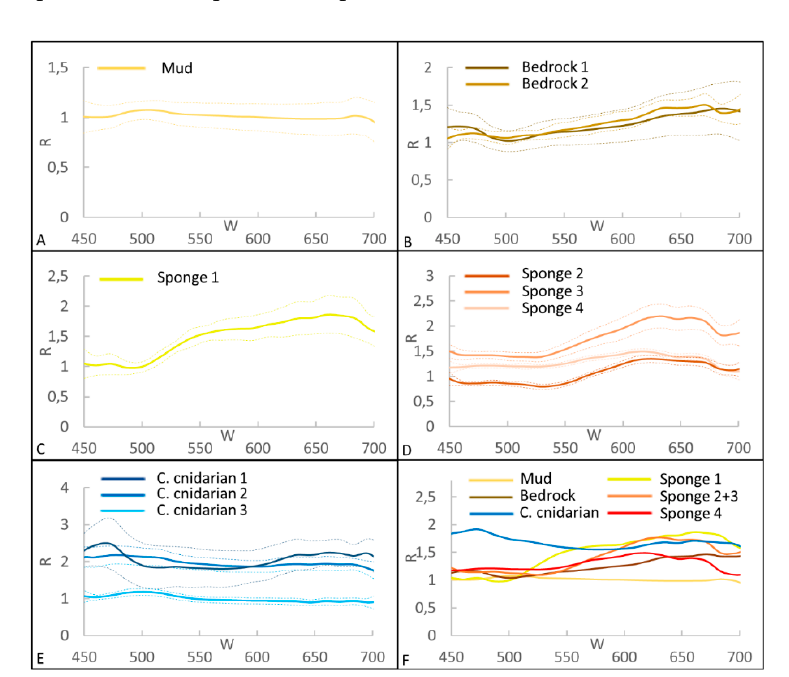
Figure 2. Mean spectra of the ROIs for the CWC site. R is the reflectance and W the wavelength. In A , B , C , D and E , dashed lines represent the standard deviation. F shows the synthesis of all spectra.